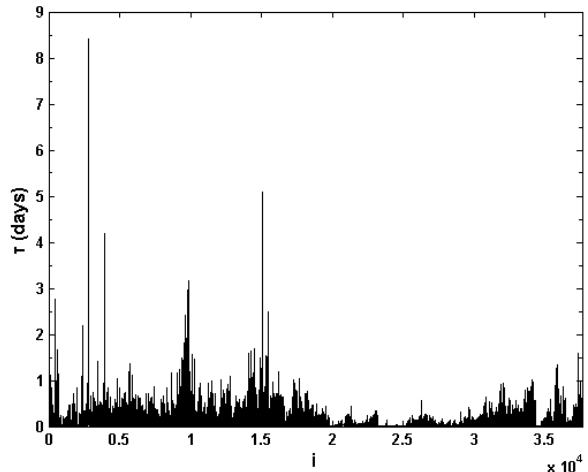
Fig. 3. The interevent time series τ of the earthquake activity for Figure 3: The inter-event time series τ of the earthquake activity for M ≥ M c versus 2 M ≥ M c versus their index number i ( i = 1 ,...,N where N is the their index number i ( i =1,…, N where N is the total length). 3 total length).